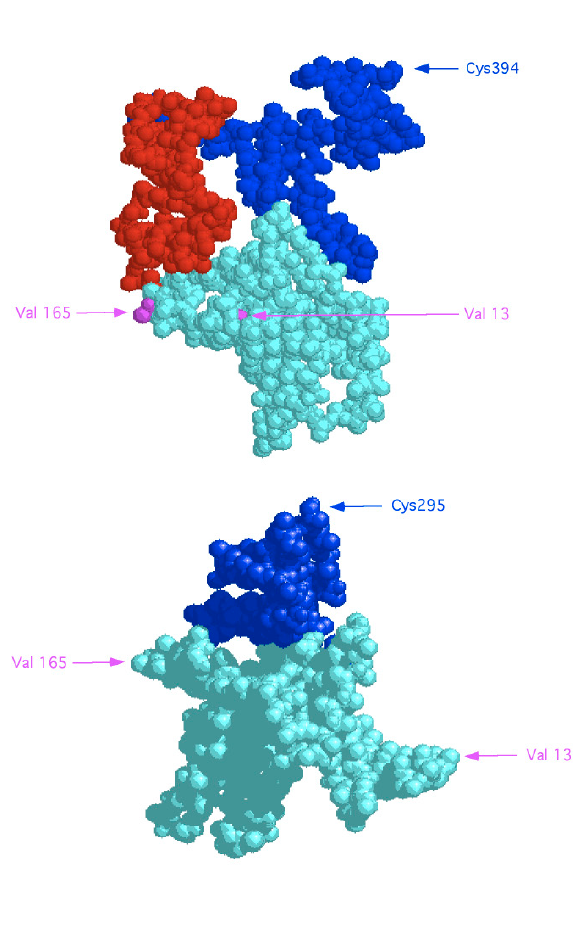
Figure 6. Hypothetical structure of wild-type Ndrg1 (upper) and the Ndrg1 str mutant (lower) proteins. Certain residues are indicated for reference. Cyan, amino acids prior to #199; red, residues encoded by exons deleted in the Ndrg1 str mutant; blue, residues 298-end of wild-type